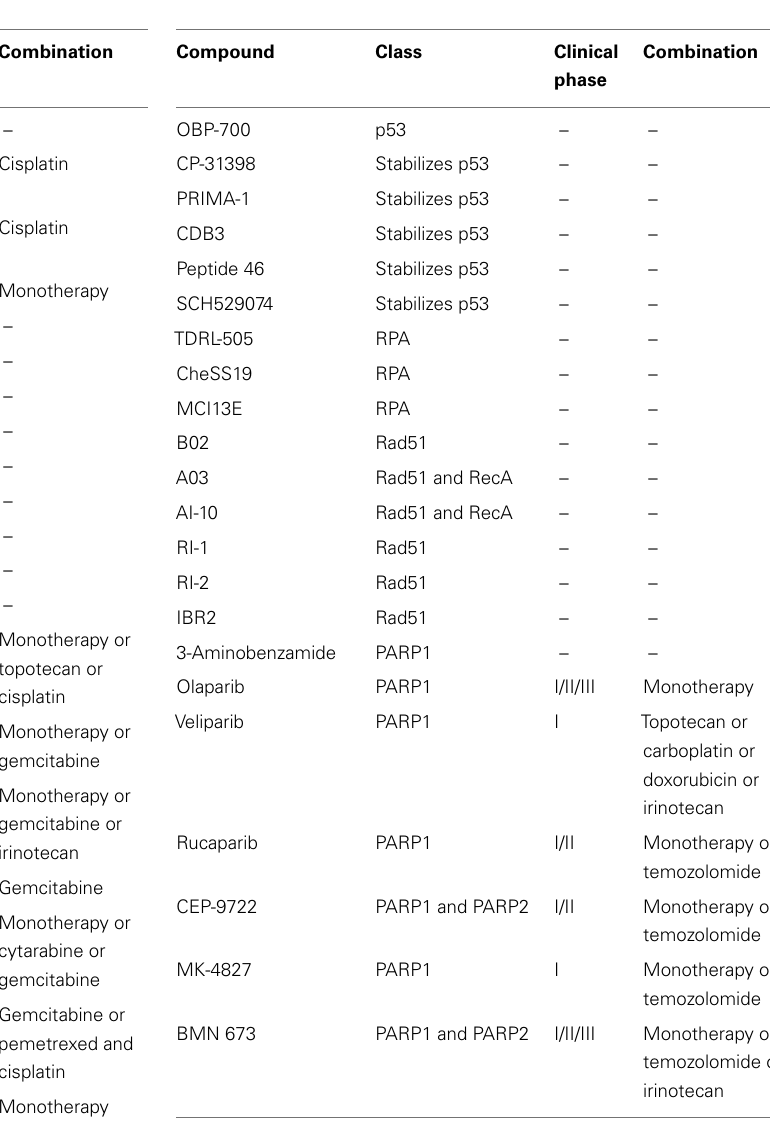
Table 1 | Chemotherapeutic compounds targeting the homologous recombination DNA repair